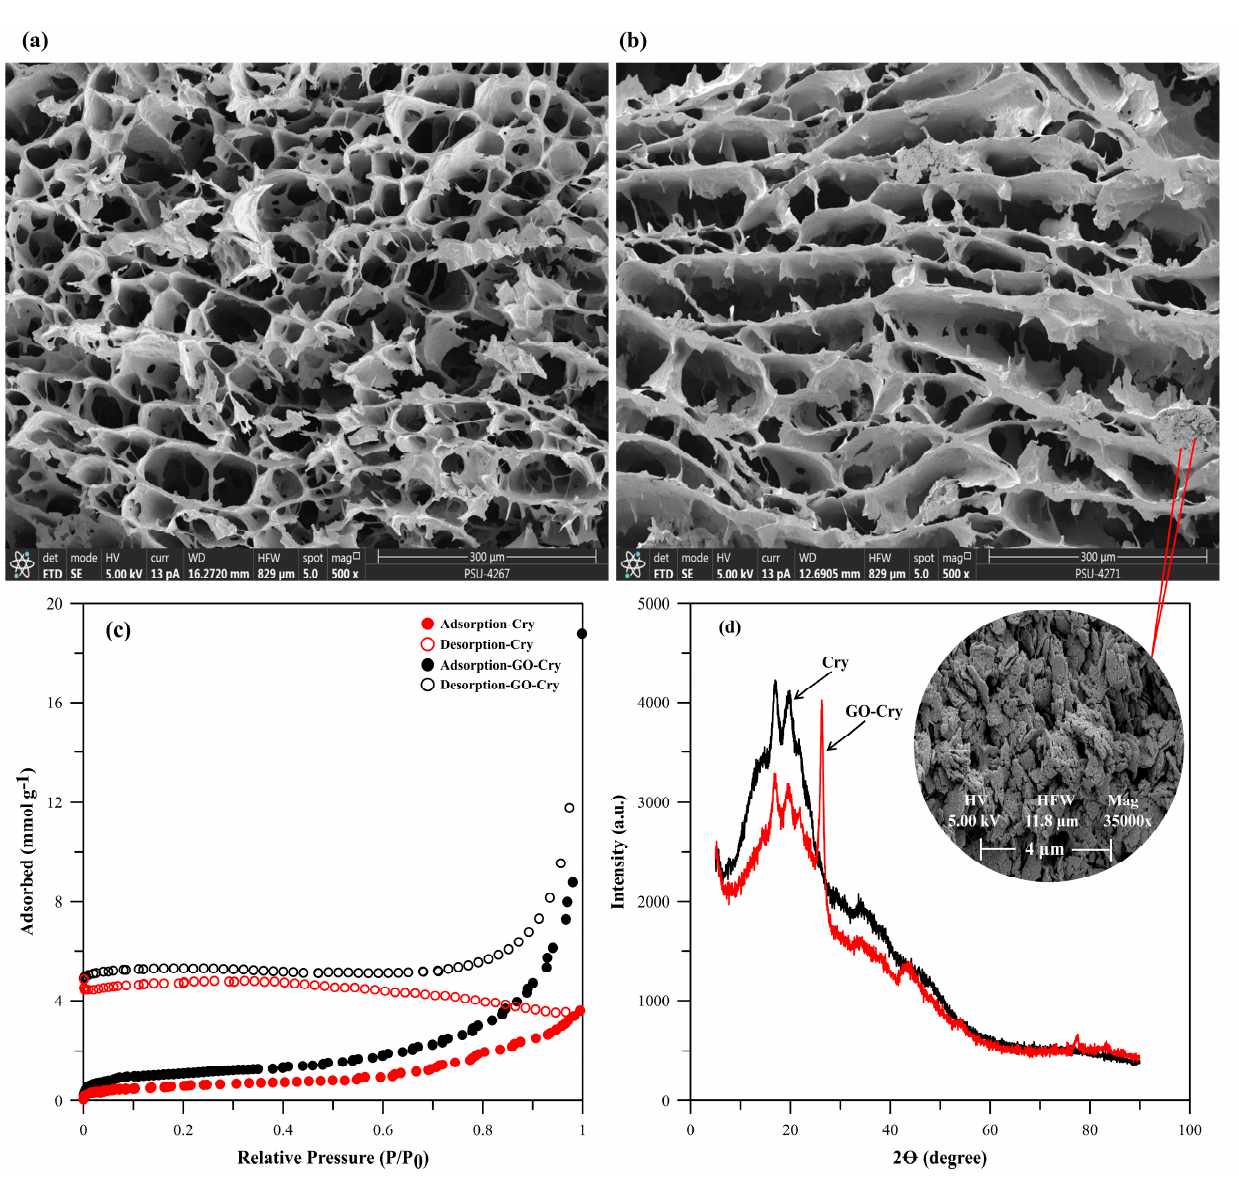
Figure 3. ( a , b ) SEM images, ( c ) Nitrogen adsorption isotherms, and ( d ) XRD patterns of Cry and GO-Cry.